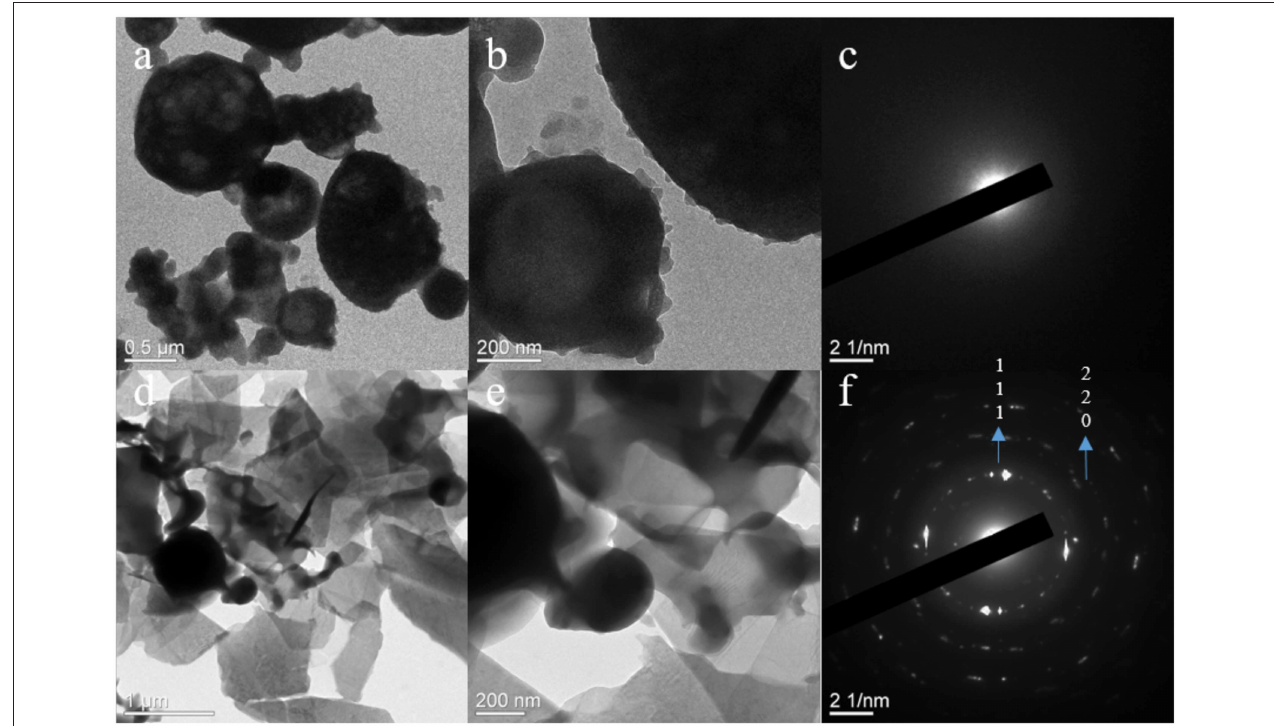
FIGURE 6 | TEM images and corresponding SAED pattern for as-synthesized particles from (a–c) sucrose-based solutions and (d–f) DMF-based